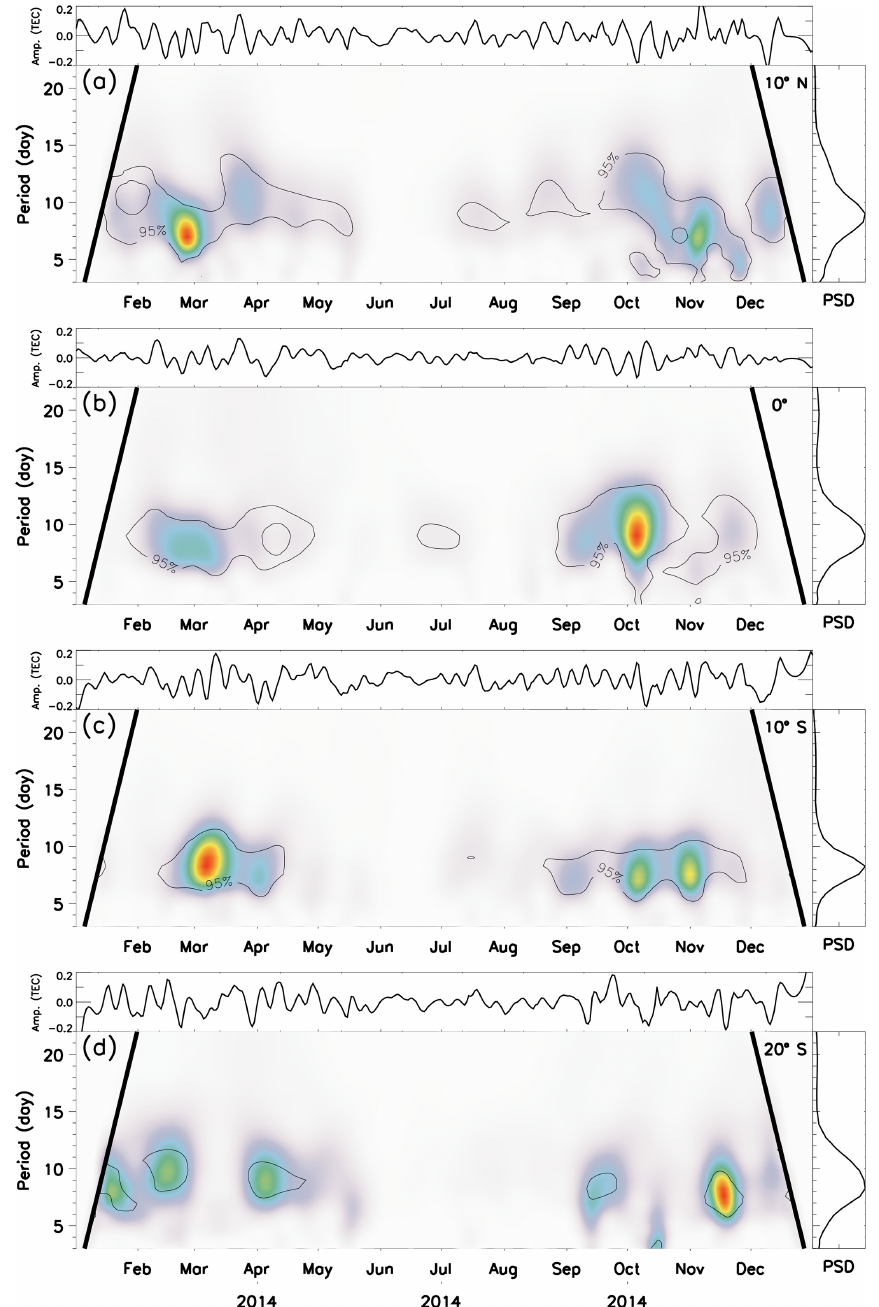
Figure 9. Same as Fig. 5 but for